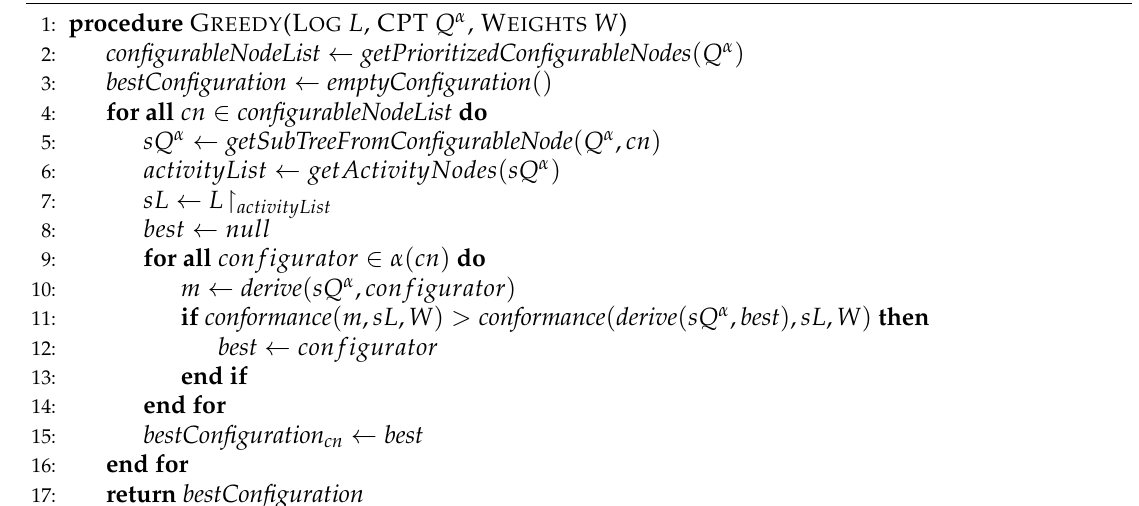
Algorithm 3 Obtaining a configuration based on the greedy